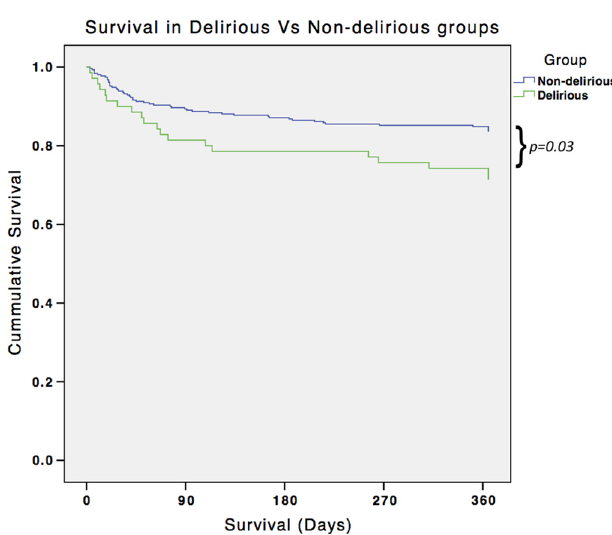
Figure 1. Kaplan Meier plot.